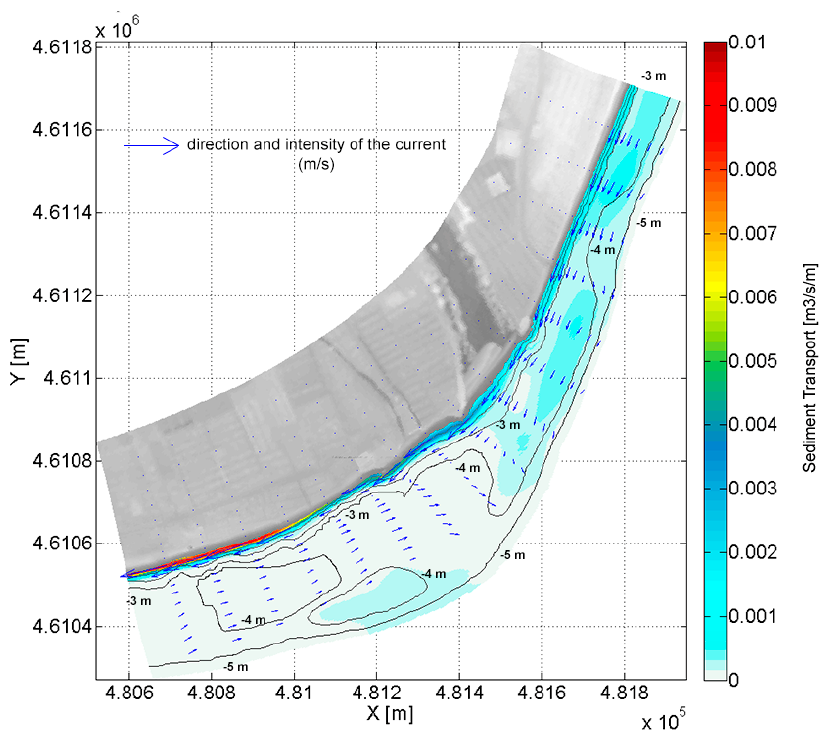
Figure 7. Simulated depth-averaged currents and sediment transport. Mean XBeach output at each 1 h time-step is averaged during the 4 h of maximum storm intensity.